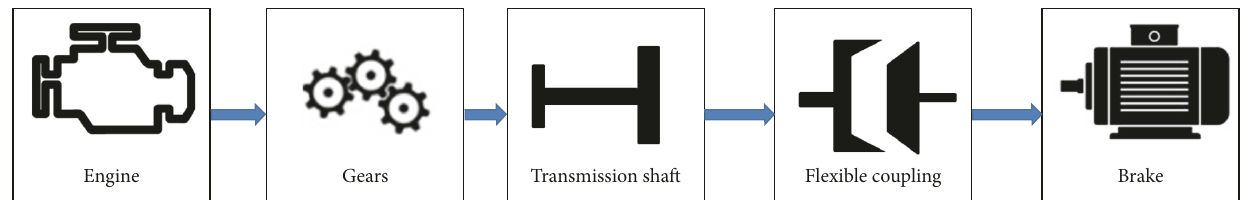
Figure 2: Schematic of the system under study.